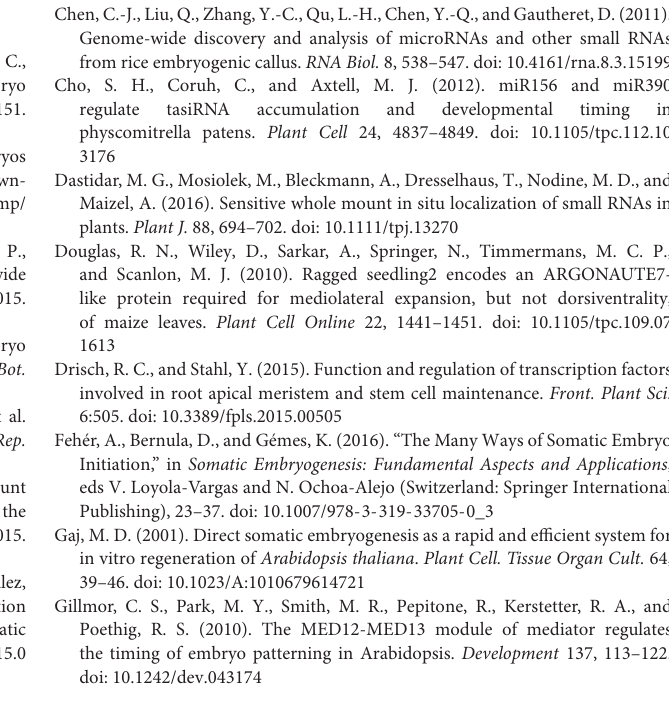
FIGURE S1 | Relative amount of mature miR167 molecules at 0th, 5th, and 10th days of the Col-0 SE culture. Bars represent the standard deviation ( n = 3). The relative transcript level was normalized to the internal control ( At4g27090 ). Values that were significantly different from the 0 day are indicated with an asterisk ( P < 0.05; n = 3 ± SD). FIGURE S2 | Relative amount of mature miR166 molecules at the 0th, 5th, and 10th days of the STTM165/166 SE culture. Bars represent the standard deviation ( n = 3). The relative transcript level was normalized to the internal control ( At4g27090 ). Values that were significantly different from the Col-0-derived culture of the same age are indicated with an asterisk ( P < 0.05; n = 3 ± SD). FIGURE S3 | Light microscopy and scanning electron microscopy images of the primary and secondary somatic embryos in the SE culture of Arabidopsis on the medium with 5 µ M of 2,4-D. PSE – primary somatic embryos; SSE – secondary somatic